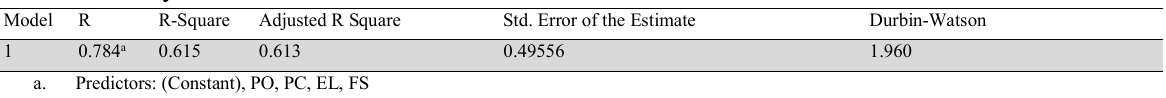
Model summary b